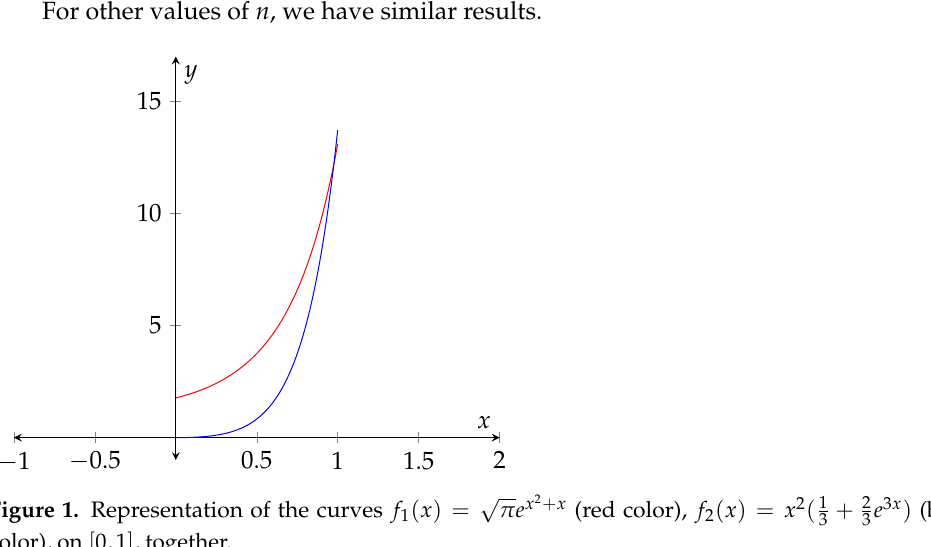
+ 2 e 3 x ) (blue 3 3